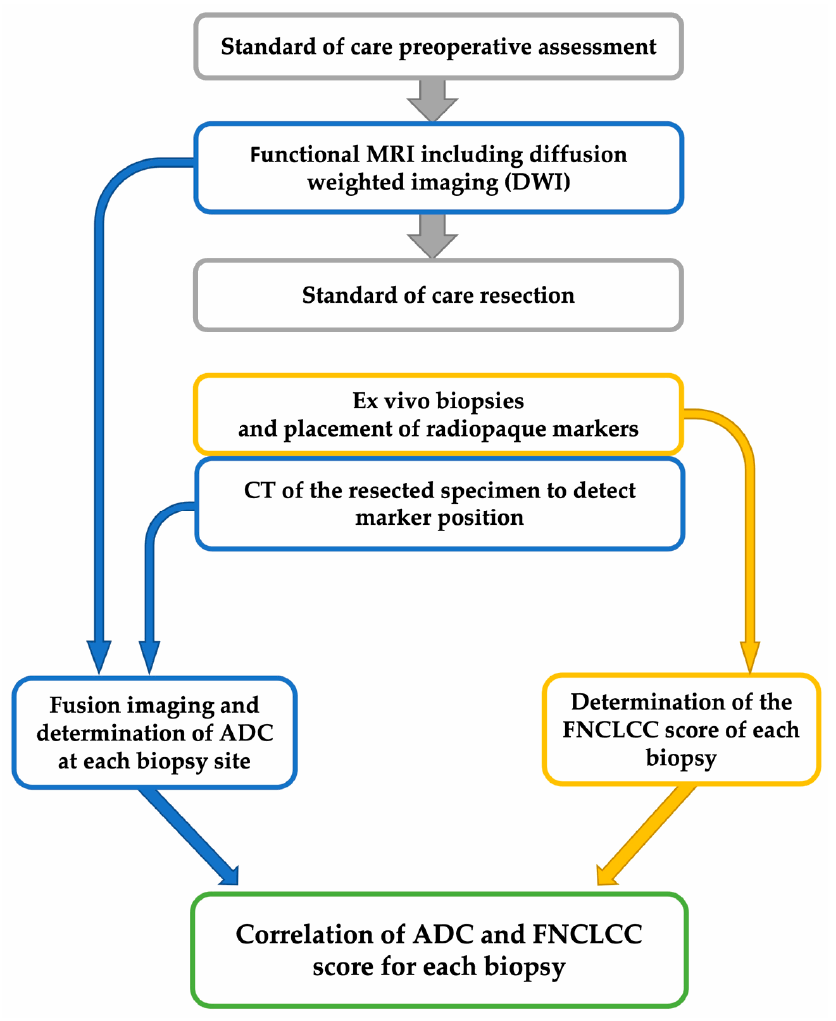
Figure 1. Study workflow. CT: computed tomography; ADC: apparent diffusion coefficient; FNCLCC: F é d é ration Nationale des Centres de Lutte Contre Le